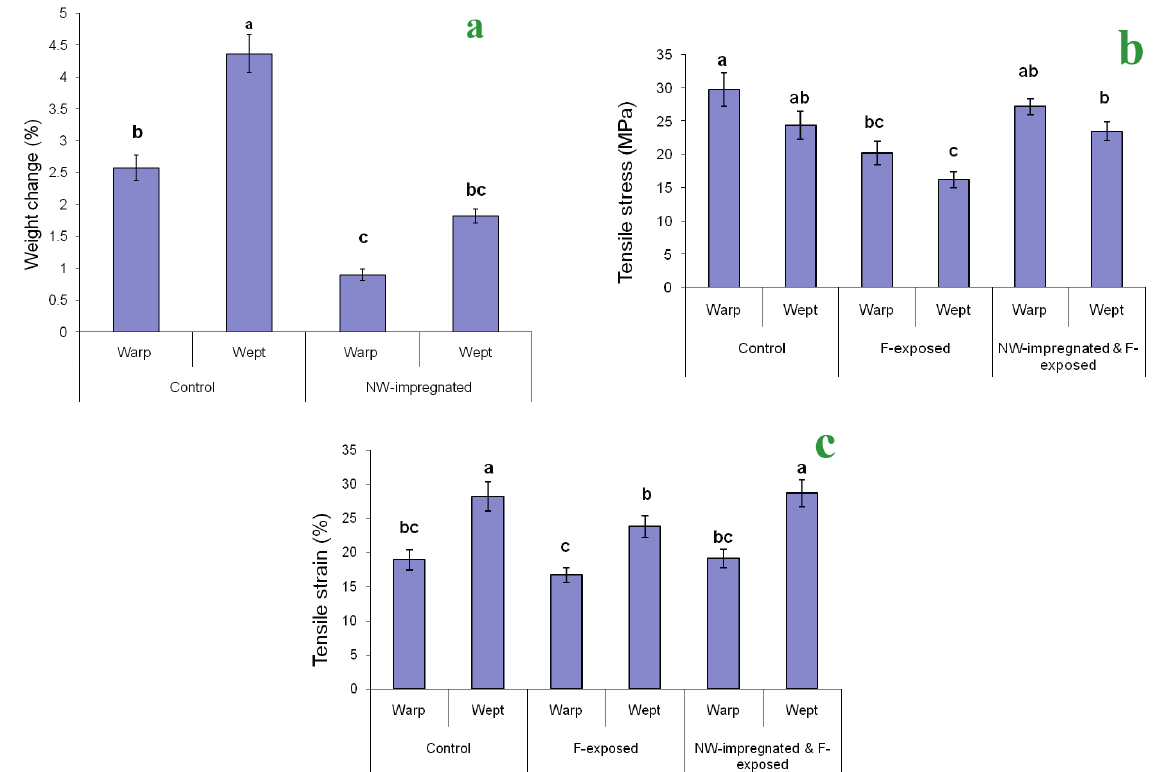
Figure 3 - Weight changes ( a ), tensile stress ( b ), and tensile stress ( c ) values in the control and NW-impregnated cotton cloth specimens in warp and wept directions, exposed to A. nigra for three months (capital letters on each column represent Duncan’s groupings).